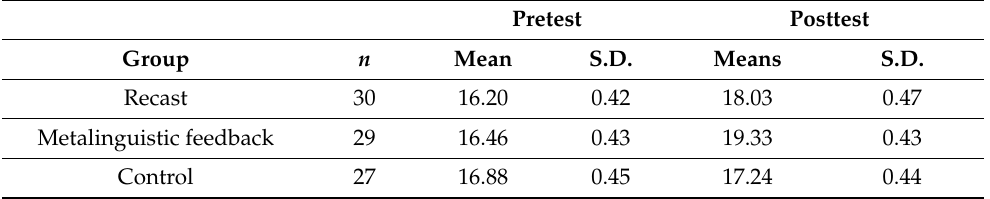
Table 3. Students’ performance in the pretest and the posttest in each treatment